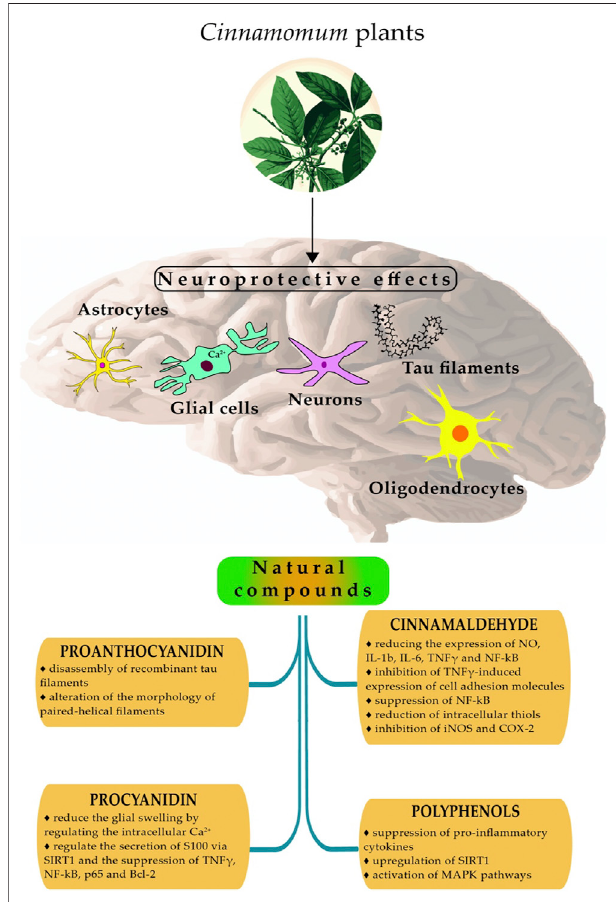
FIGURE 4 | Summarized mechanisms of neuroprotective effects of Cinnamomum plants. Abbreviations: SIRT1, Sirtuin 1; MAPK, mitogen- activated protein kinase; iNOS, inducible Nitric Oxide synthase; TNF- γ , tumor necrosis factor; COX-2, Cyclooxygenase-2; NF-kB, Nuclear Factor- Kappa B; p65 (RelA subunit of NF- κ B family of transcription factors); Bcl-2, B-cell lymphoma 2; IL-1b, Interleukin-1beta; IL-6, Interleukin 6.